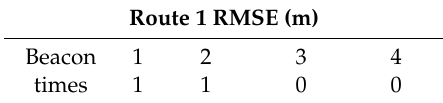
Table 4. RMSE of positioning with artificial outliers (m).